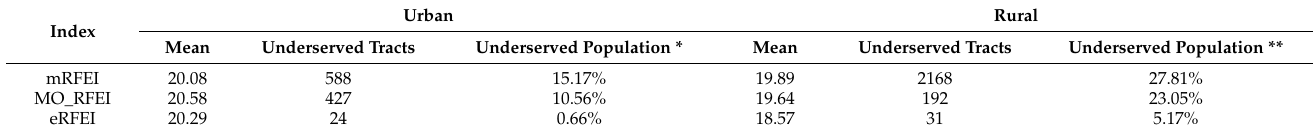
Table 2. Urban and rural comparison of Floridian food